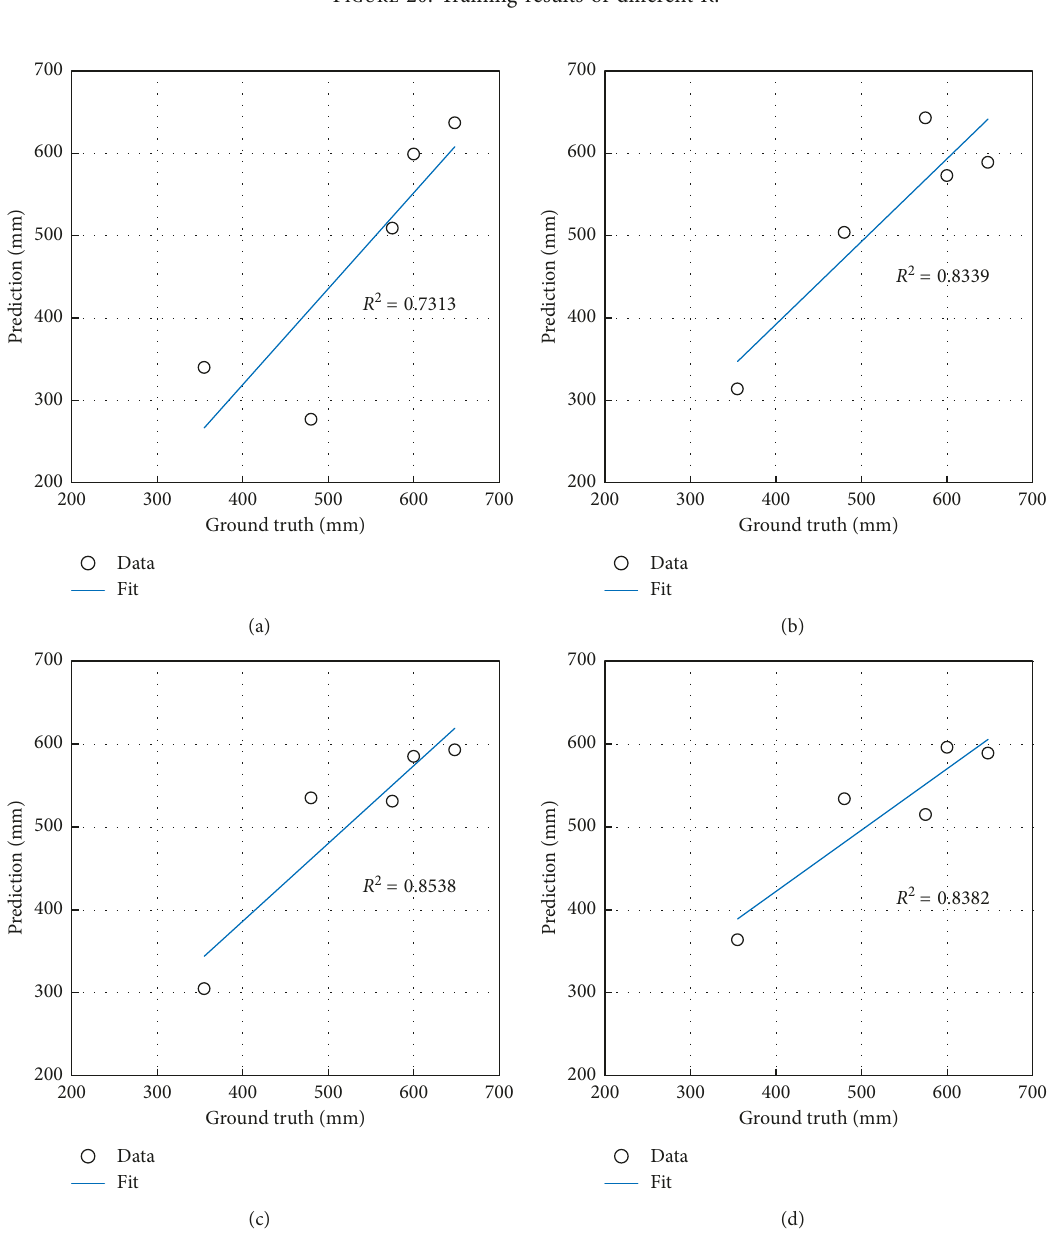
Figure 21: Prediction results of SF values with different R : (a) R � 3; (b) R � 5; (c) R � 7; (d) R � 9.